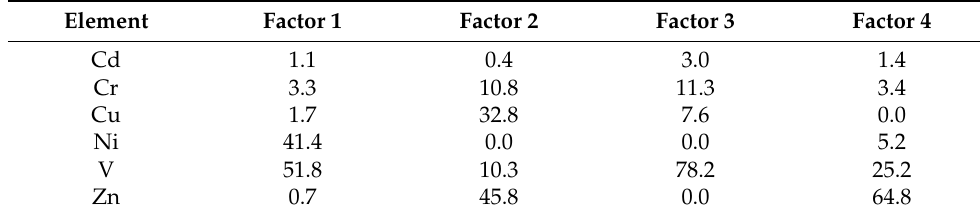
Table 6. Percentage of heavy metal contribution per source.